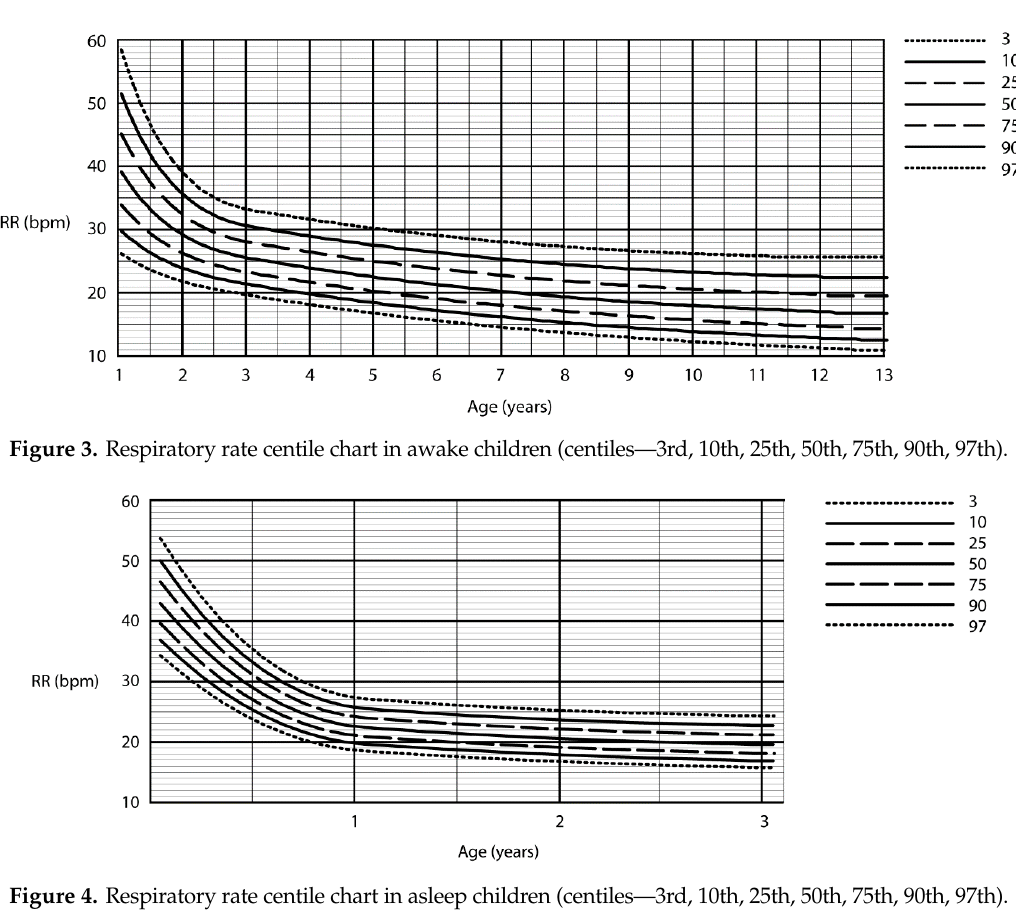
Figure 4. Respiratory rate centile chart in asleep children (centiles—3rd, 10th, 25th, 50th, 75th, 90th, 97th).